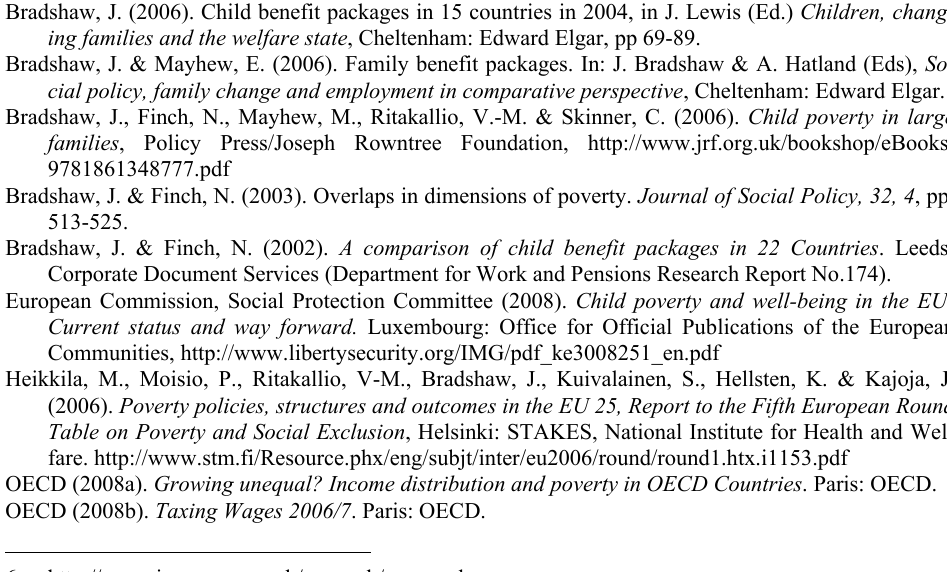
Table on Poverty and Social Exclusion , Helsinki: STAKES, National Institute for Health and Wel- fare. http://www.stm.fi/Resource.phx/eng/subjt/inter/eu2006/round/round1.htx.i1153.pdf OECD (2008a). Growing unequal? Income distribution and poverty in OECD Countries . Paris: OECD. OECD (2008b). Taxing Wages 2006/7 . Paris: